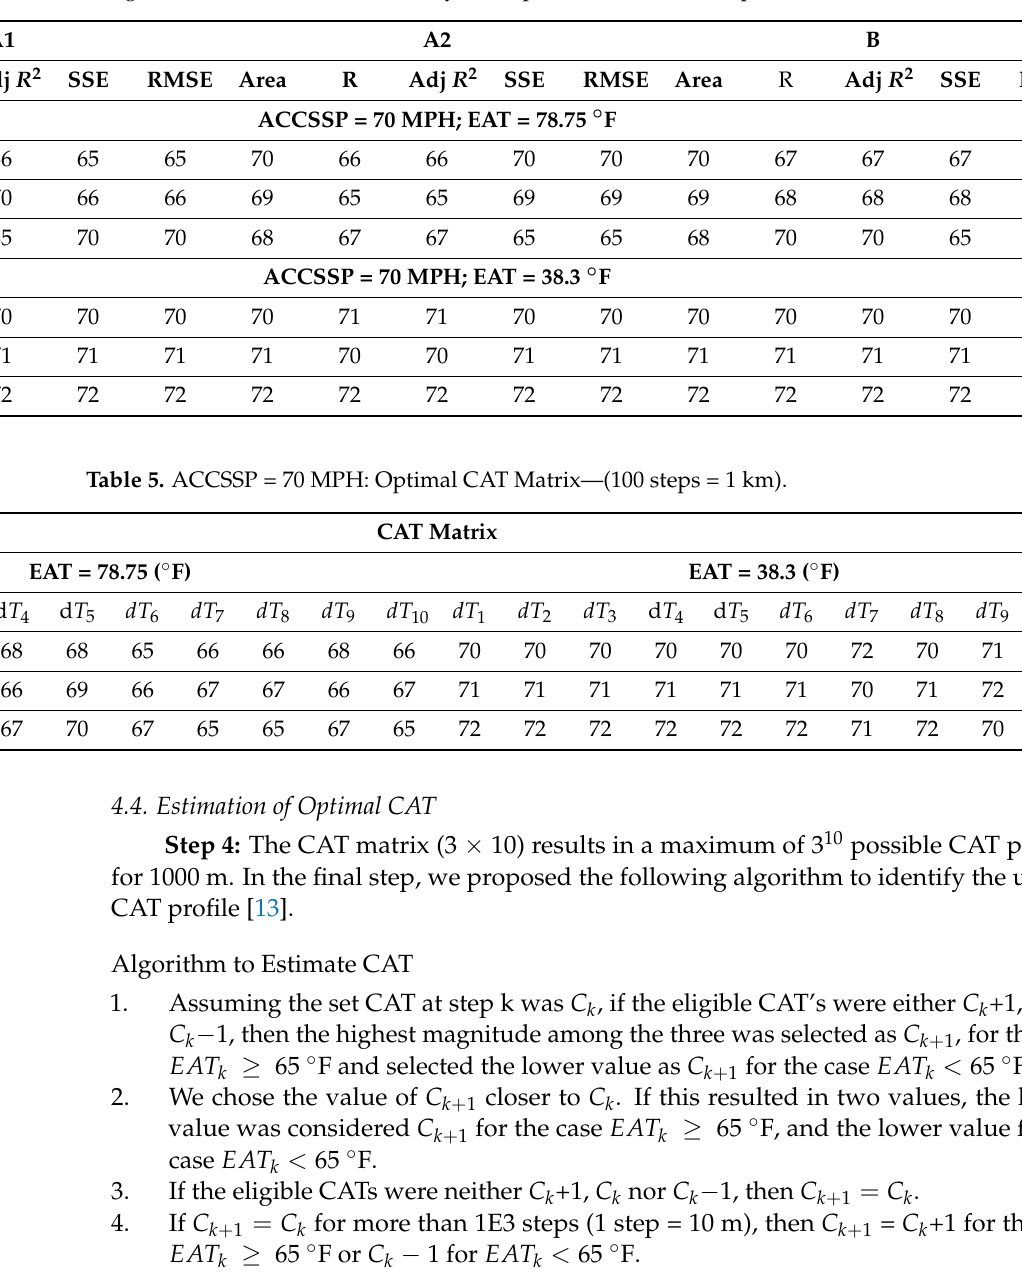
Table 4. Eligible CAT Values: Iterative Analysis—Optimal CATOP. (10 steps = 100 m).